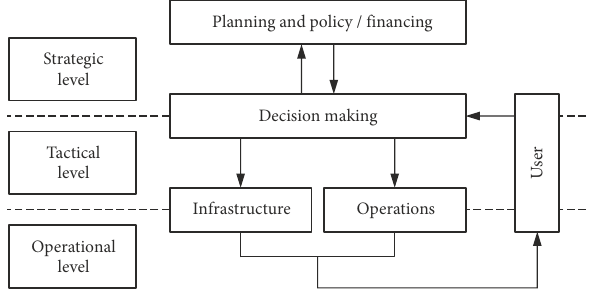
Figure 1. Decision-making framework (CLOSER 2012)